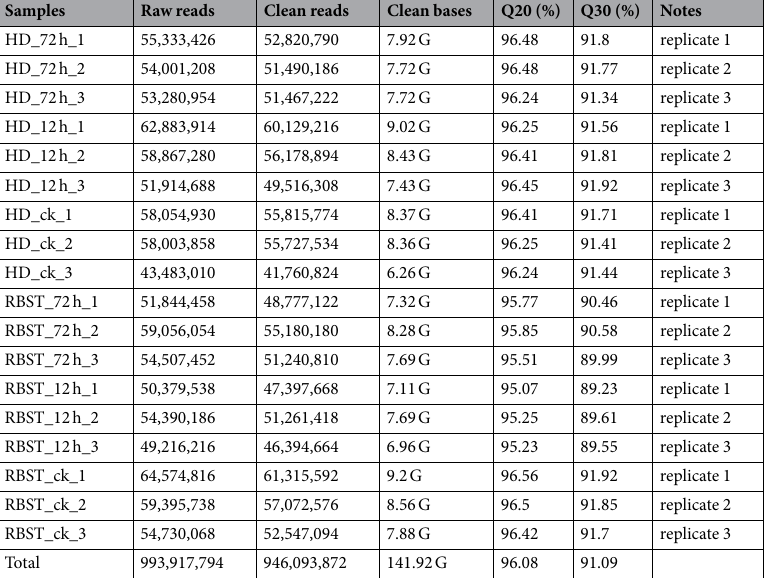
Table 1. Statistics of Illumina sequencing